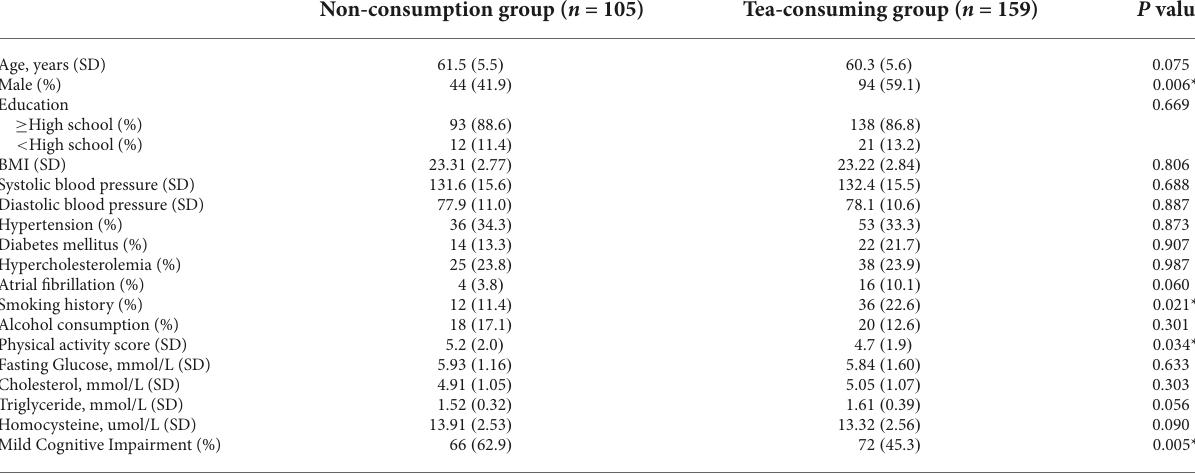
TABLE 2 Demographic and clinical characteristics of tea-consuming and non-consuming